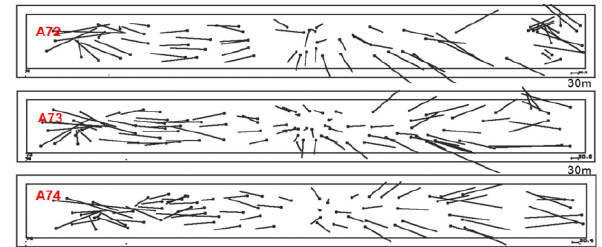
Figure 7. Discrepancies of 3 resections at